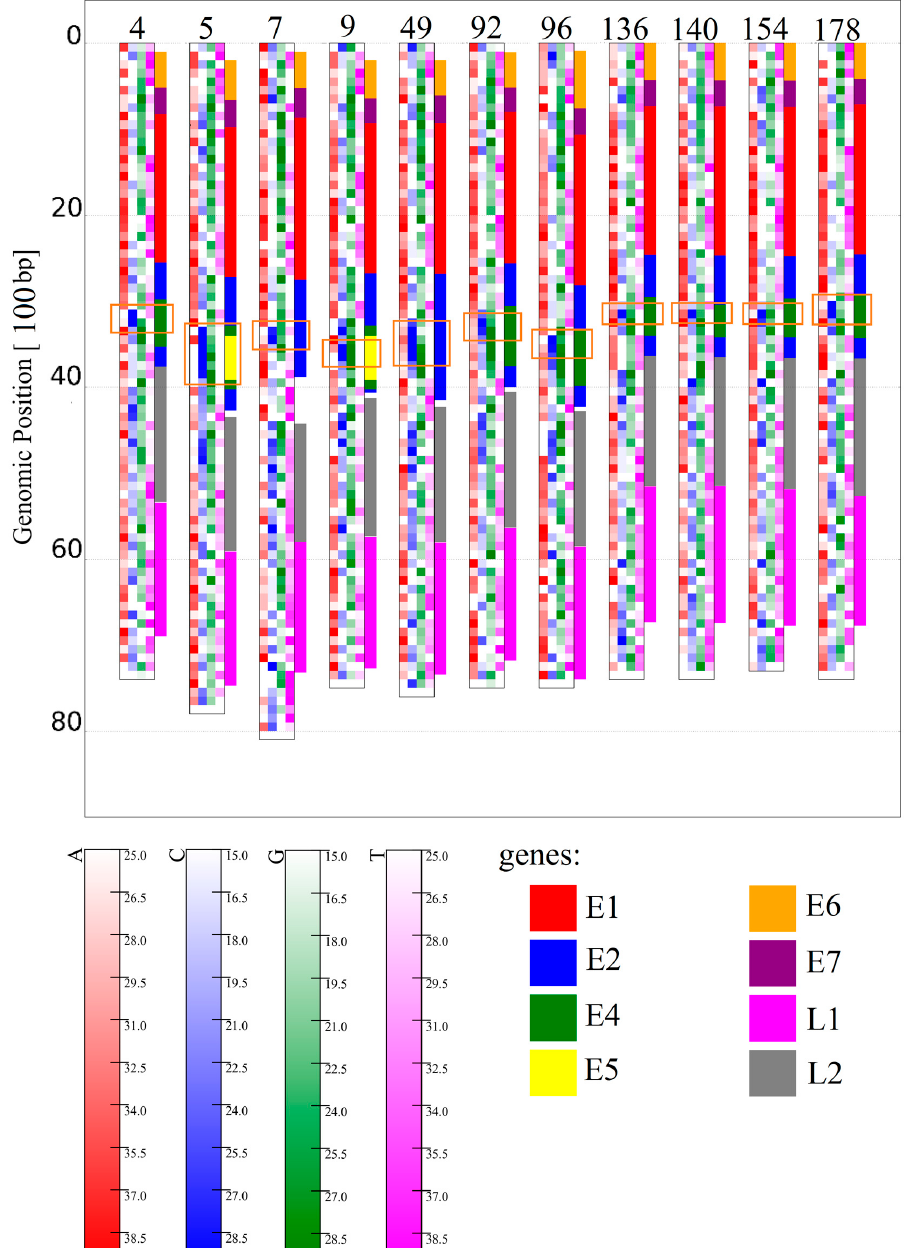
Figure 1. Map of Human Papillomaviruses (HPVs) for k = 1. From left to right: HPV4, 5, 7, 9, 49, 92, 96, 136, 140, 154, 178. A bin width of 100 bp was used. Genes were represented by colored bars at the right side of the linear representation of the circular HPV genomes (E1 red, E2 blue, E4 green, E5 yellow, E6 orange, E7 purple, L1 magenta, L2 grey). The orange boxes indicate the boundaries of the three regions with different k -mer structures (the regions above and below the middle region in the box do not have their own boxes for easier readability).